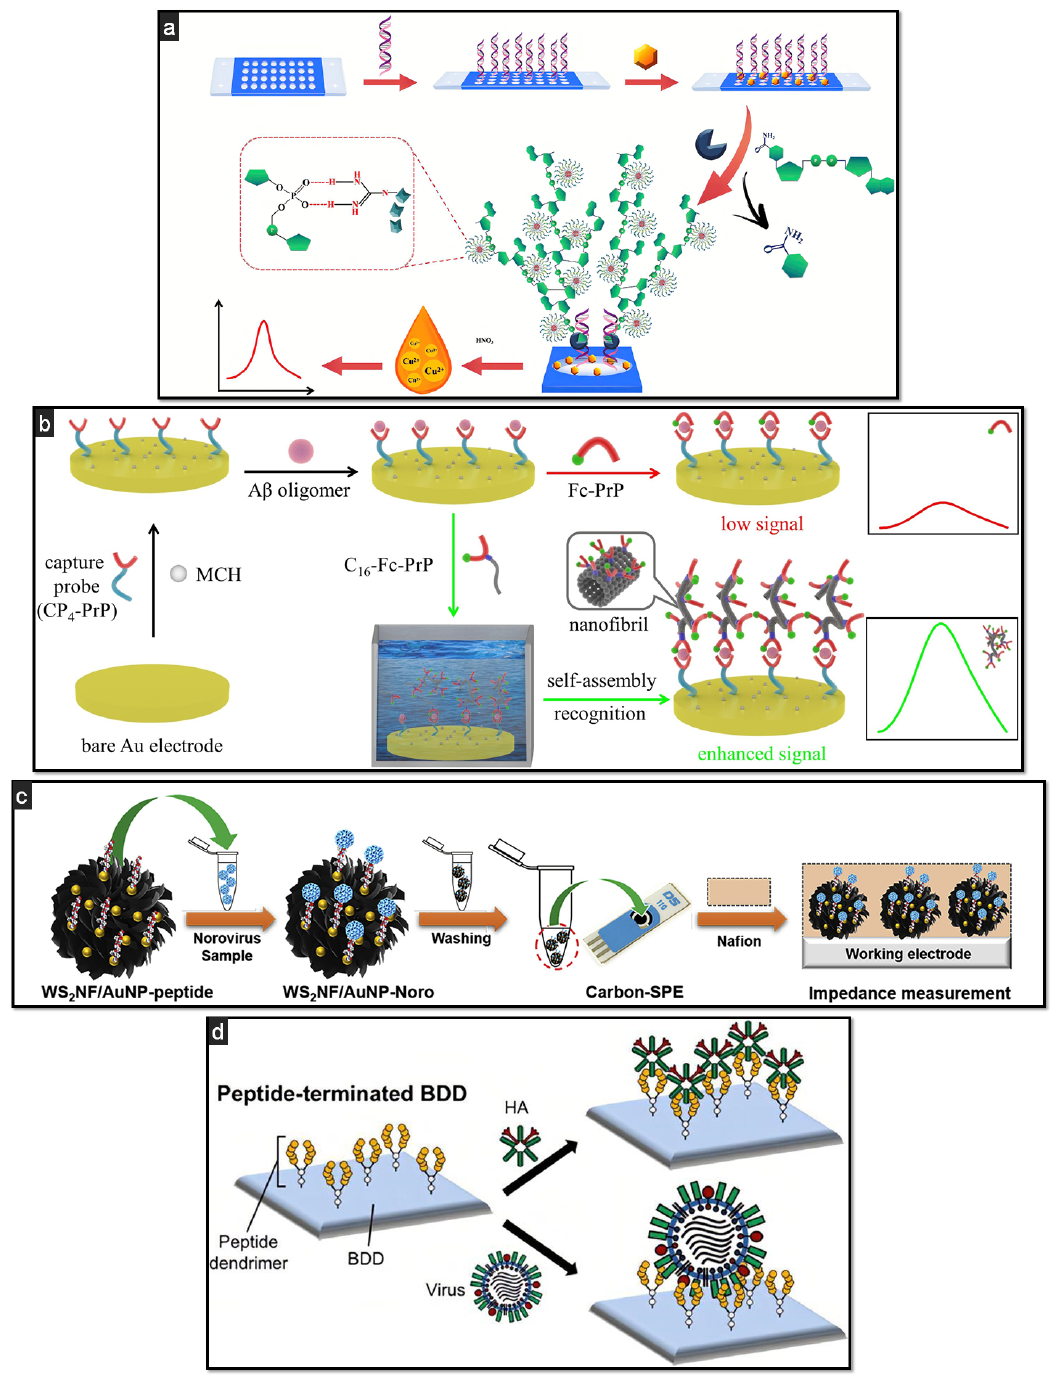
Figure 3. Schematic representation of some examples of peptide-based affinity platforms: ( a ) peptide-templated CuNPs as a probe for the detection of PARP-1, recognising and labelling PAR (PARP-1 catalysed form) by covalent-like interactions between guanidine groups and phosphate groups of PAR; quantitative determination via trace-level stripping voltammetry, reprinted with permission from [95]; ( b ) signal amplification strategy based on in situ peptide self-assembly for the detection, through SWV, of A β oligomer by designing a sandwich with a prion protein residue (PrP) that worked as a capture and Fc-conjugated signalling probe, reprinted with permission from [106]; ( c ) design of the label-free detection scheme based on peptide-functionalised WS 2 NF/AuNPs for norovirus through EIS analysis, reprinted with permission from [115] ( d ) HA and avian influenza virus immobilisation at BDD electrodes in a Fc-labelled approach, reprinted with permission from [116] Copyright (2020) American Chemical Society.